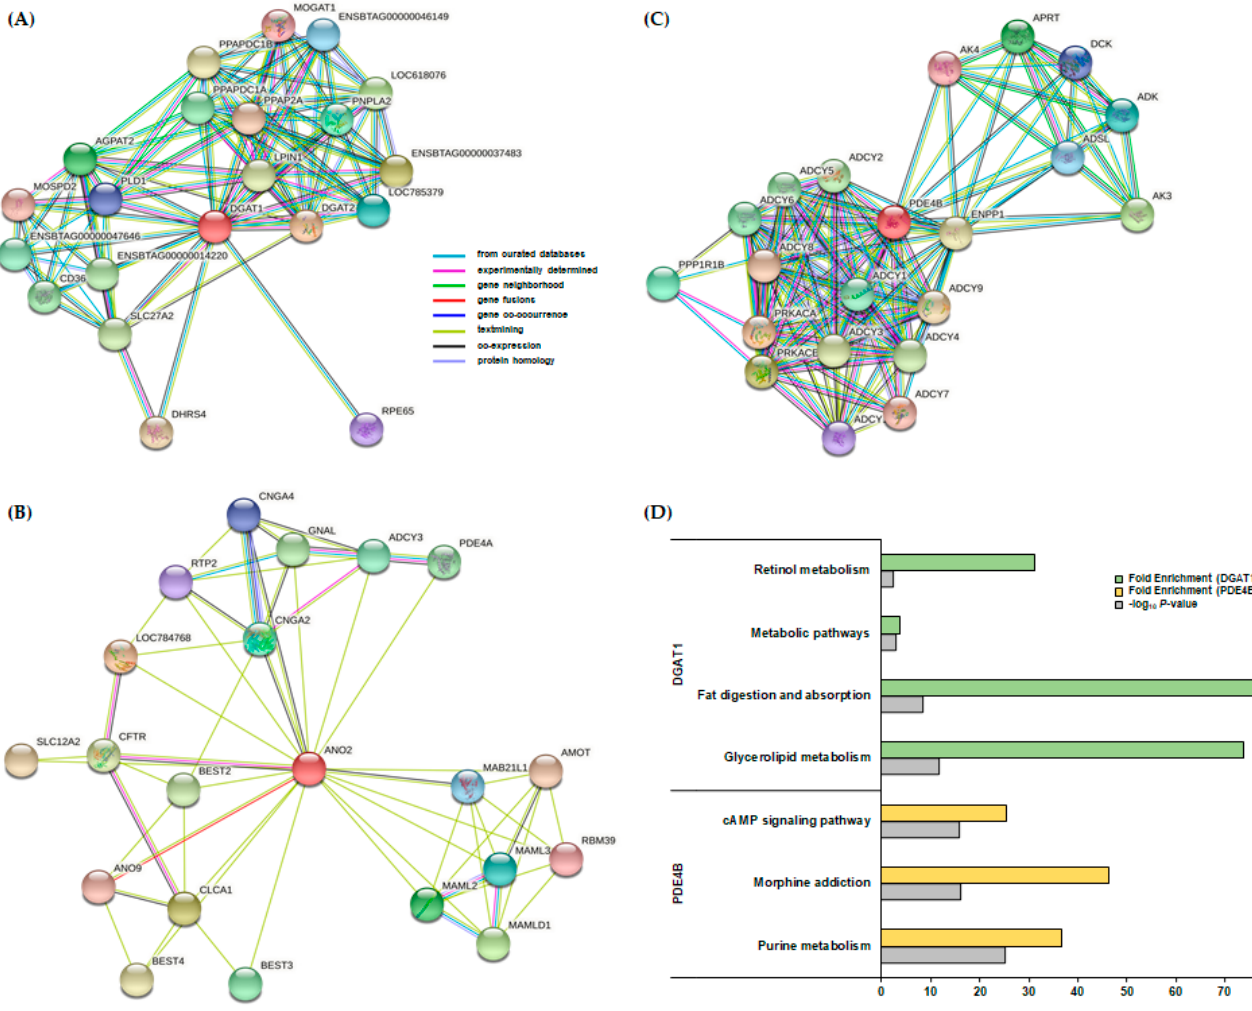
Figure 2. Protein–protein interaction (PPI) network and Kyoto Encyclopedia of Genes and Genomes (KEGG) pathway analyses for three candidate genes ( DGAT1 , ANO2 , and PDE4B ) with 20 interactor genes. ( A ) DGAT1 with 20 interactors confirmed by PPI. ( B ) ANO2 with 20 interactors were confirmed by PPI. ( C ) PDE4B with 20 interactors confirmed by PPI. ( D ) KEGG enrichment analysis for DGAT1 and PDE4B with 20 interactors.